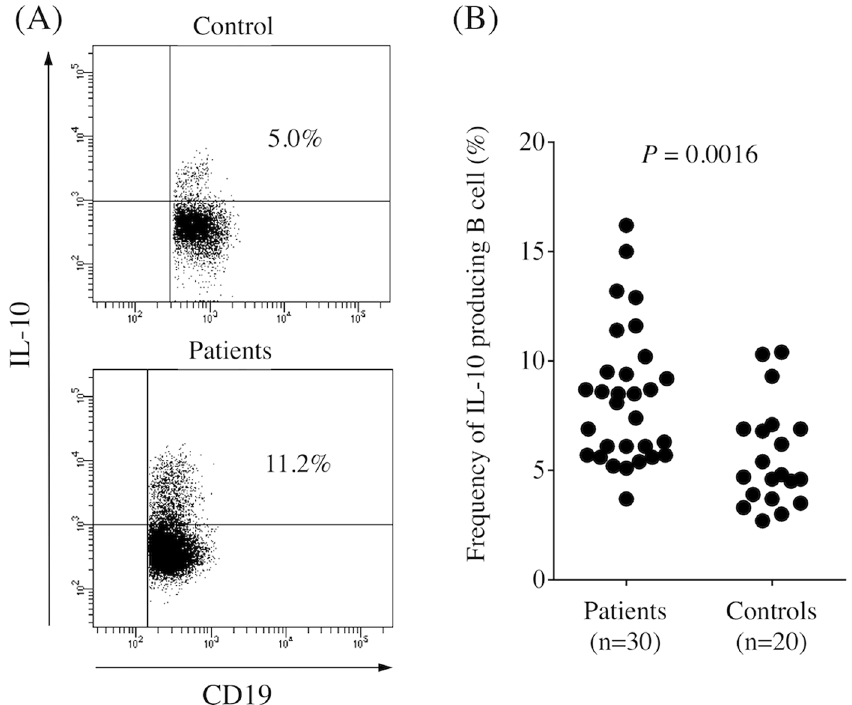
Figure 1. ( A ) Representative image of regulatory B cells in control and gastric cancer patients. ( B ) Percentage of CD19 + IL-10 + cells among CD19 + B cells in peripheral blood obtained from gastric cancer patients and healthy controls. The frequency of Bregs was significantly higher in gastric cancer patients than in healthy controls ( P =